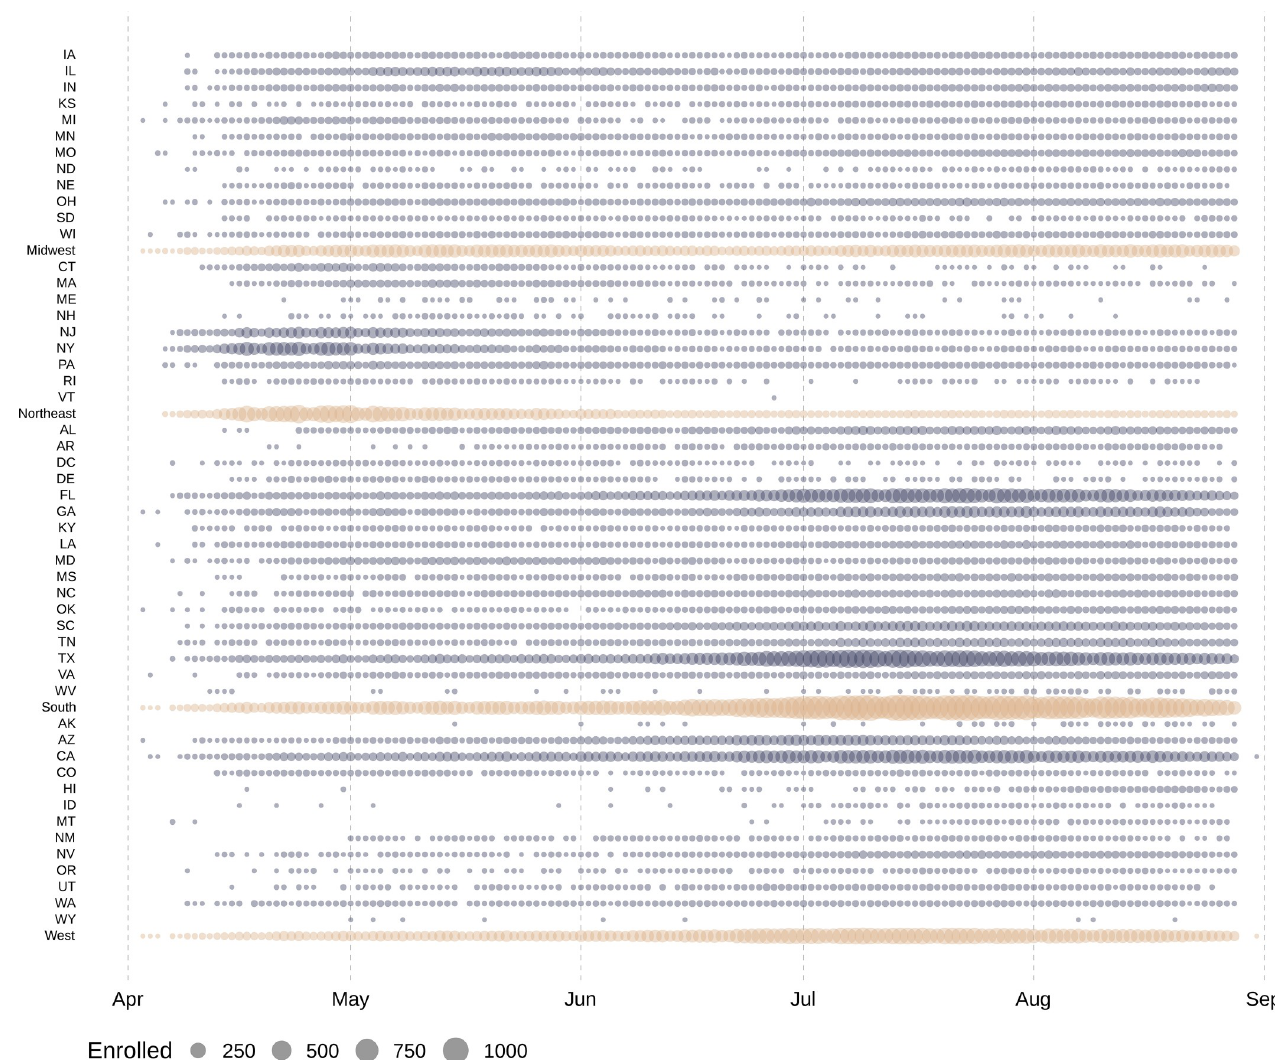
Fig 4. Daily patient enrollment in the US Expanded Access Program. Each circle AU : PleasecheckthattheeditstothelegendforFig 4 captureyourmeaning : Ifanyeditsareincorrect ; pleaseeditasnecessary : represents 1 day in which at least 1 patient was enrolled within the indicated US state or region. Grey circles represent daily US state enrollments, and tan circles represent daily US region enrollments. The size of the circle corresponds to the number of daily enrollments within the specified US state or region. States are ordered alphabetically within each US region, followed by the aggregate for each region.